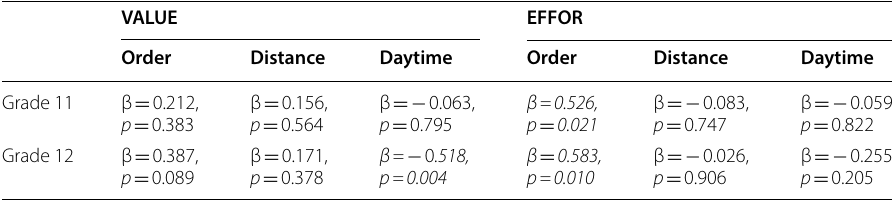
Table 6 Test administration